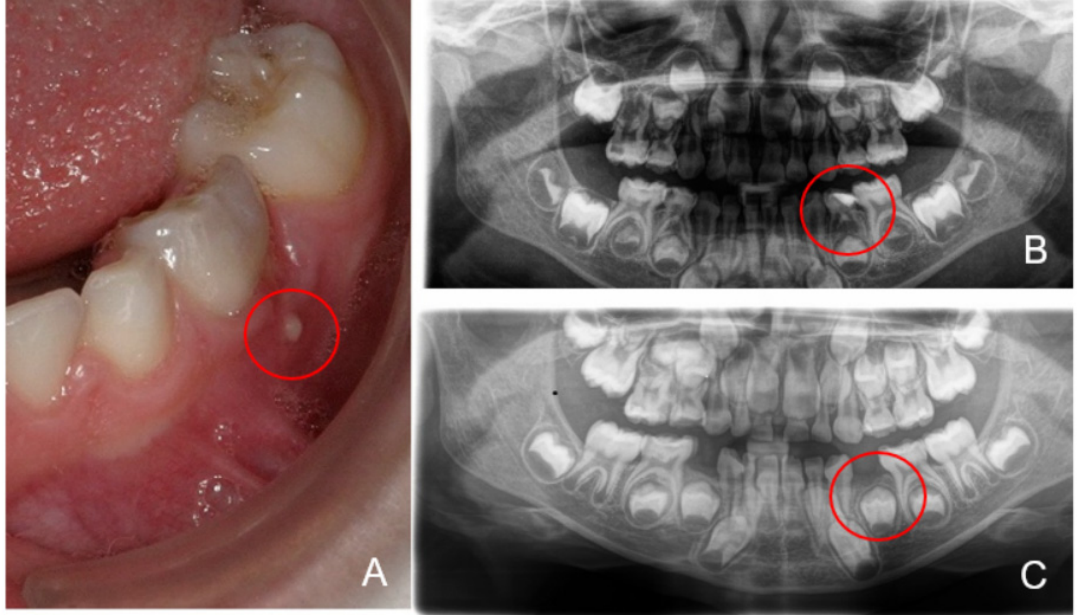
Figure 2. Patient CHD06 with severe early childhood caries (S-ECC) and fistula (marked by the red circle) of decayed tooth 74 ( A ), radiographic showing parodontitis periapicalis chronica as a result of endodontic infection with the need for extraction of tooth 74 (marked by the red circle; B ) and the post-therapy recall after extraction tooth 74 after three years (marked by the red circle; C